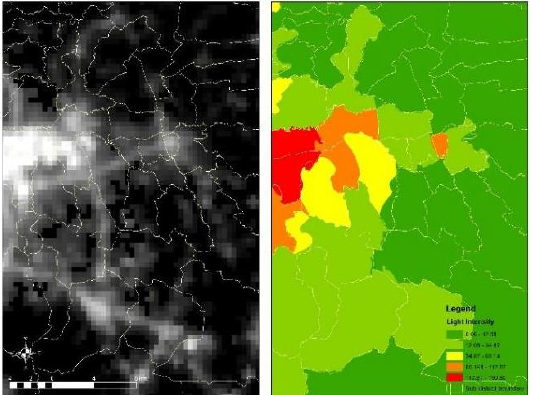
Figure 3. 2016 NTL yearly composite (left) and Night light intensity extraction by a sub-district boundary (right).